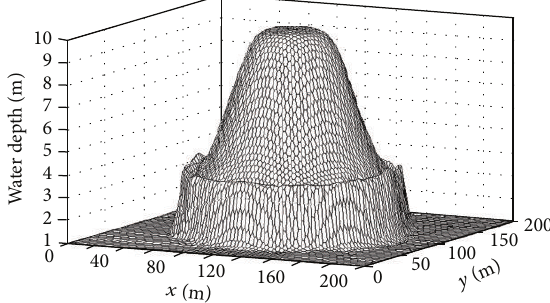
Figure 11: 2D Circular dam break problem at 𝑡 = 2 s using V-Break.